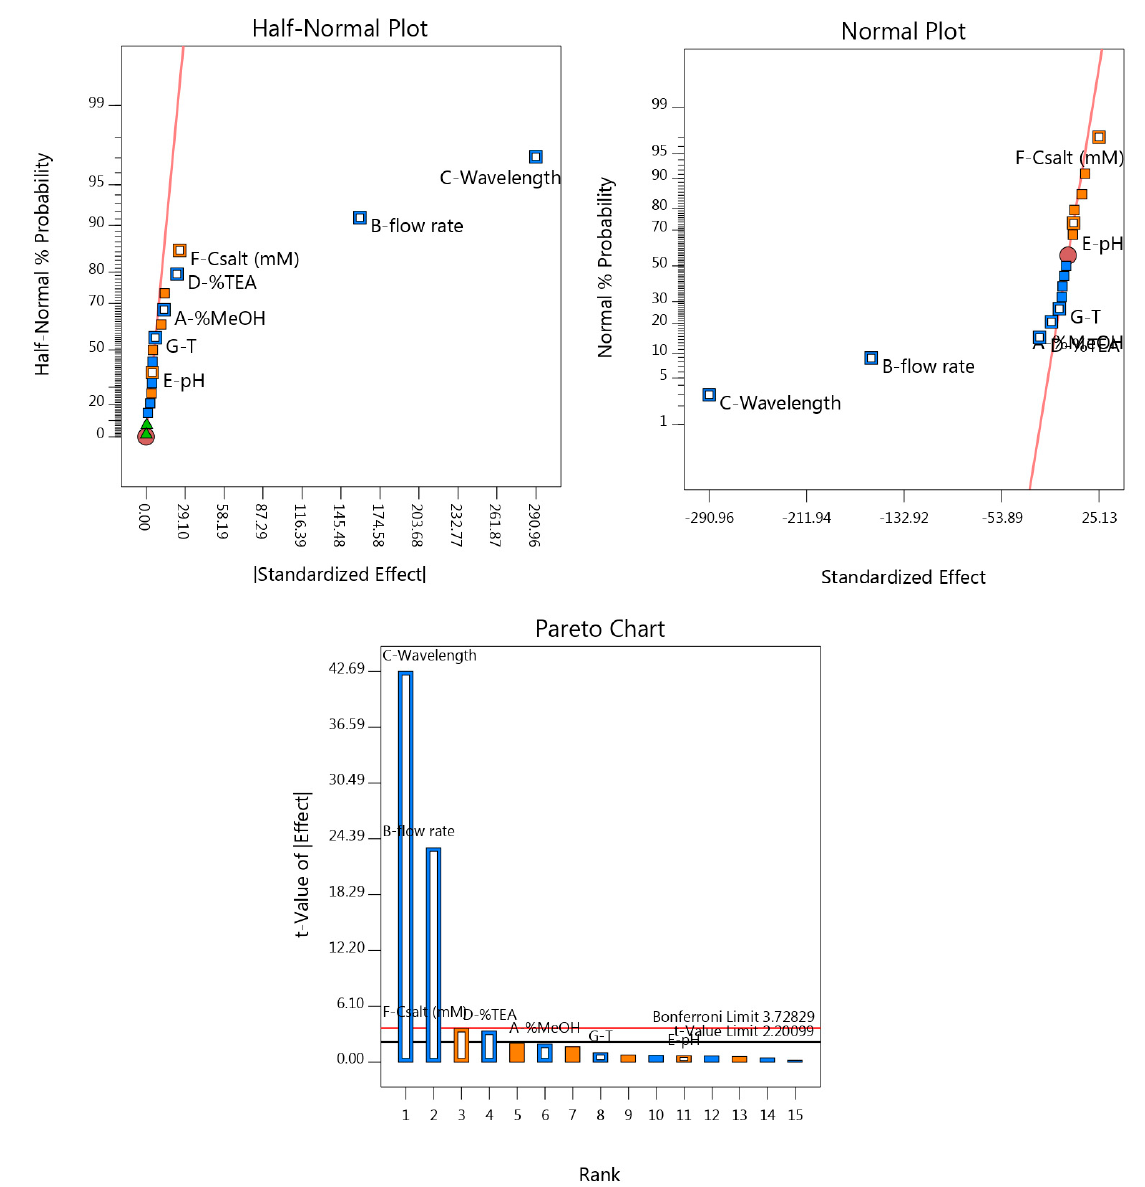
Figure 3. Half-normal and normal plots ( top ) and Pareto chart ( bottom ) for the response Area of CE. A: %MEOH, B: Flow Rate, C: λ , D: %Et 3 N, E: pH, F: Csalt, G: T.